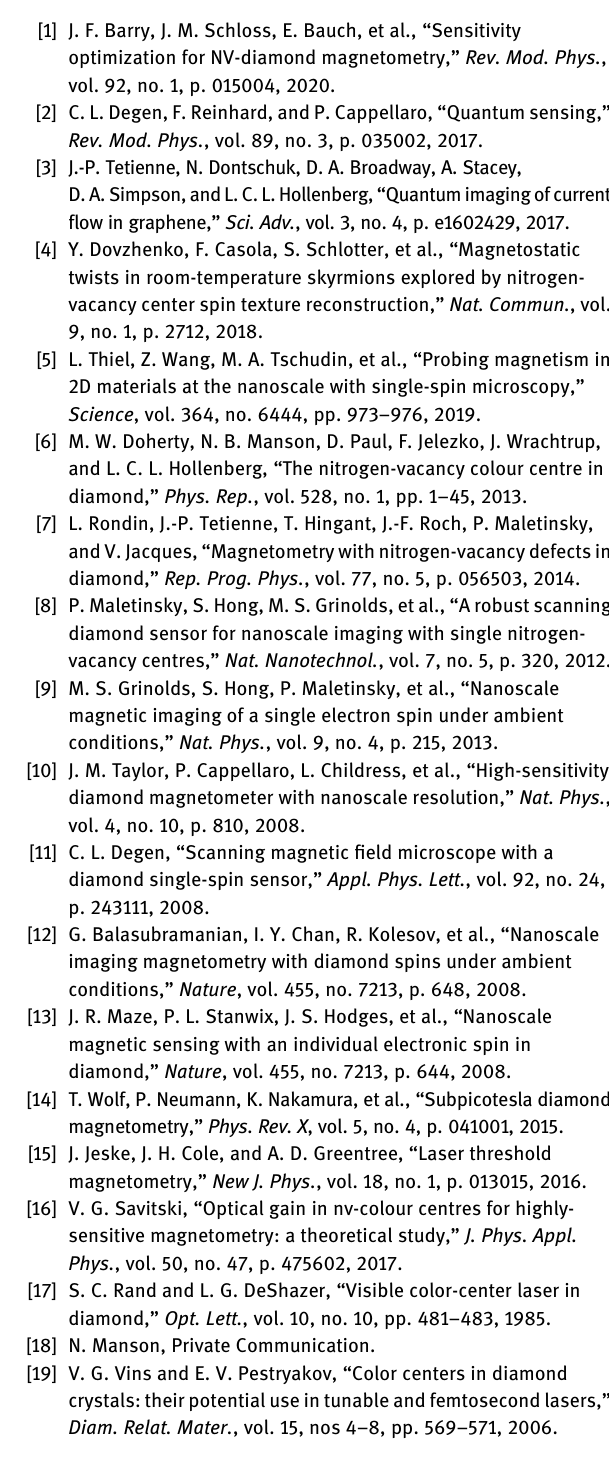
Table  : Parameters obtained from the eight Lorentian fi t functions of the spectrum.